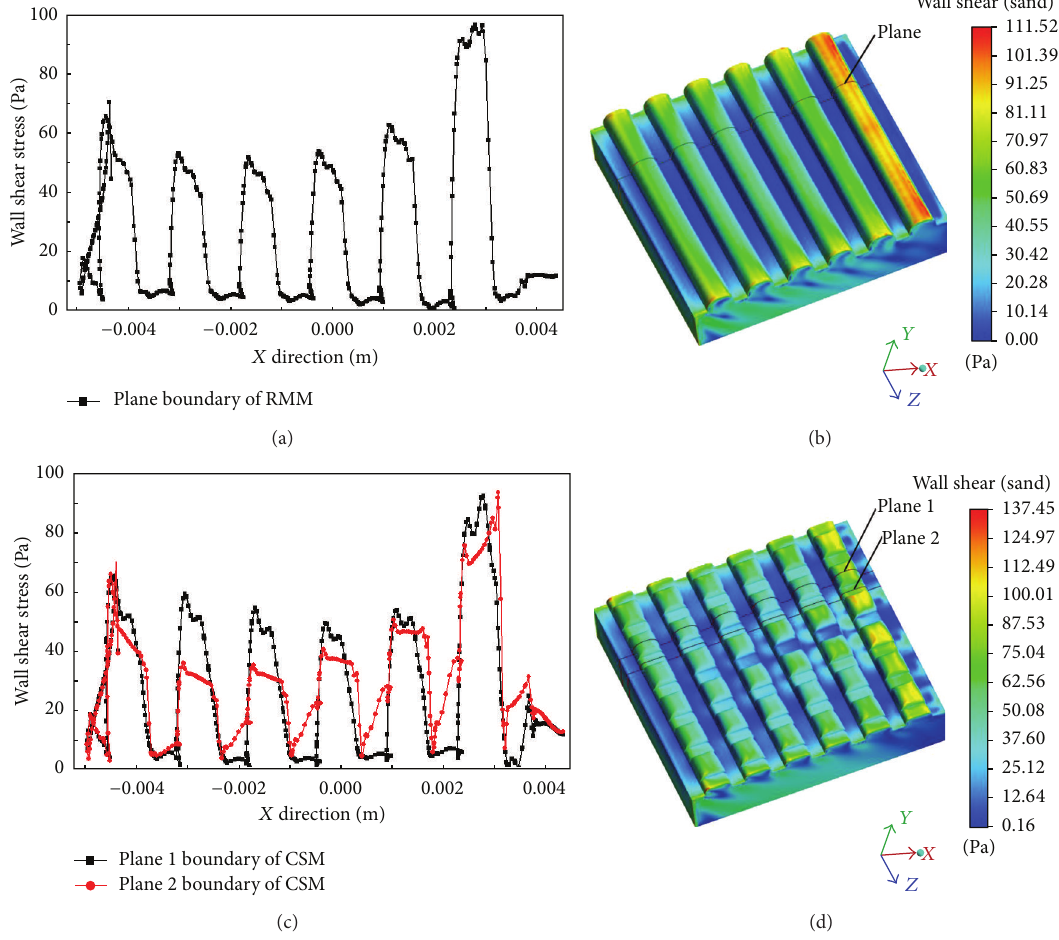
Figure 10: Shear stress nephogram and plane boundary curve of the two models: (a) shear stress curve in the plane boundary of the RMM; (b) shear stress nephogram of the RMM; (c) shear stress curve in the plane boundary of the CSM; and (d) shear stress nephogram of the CSM.